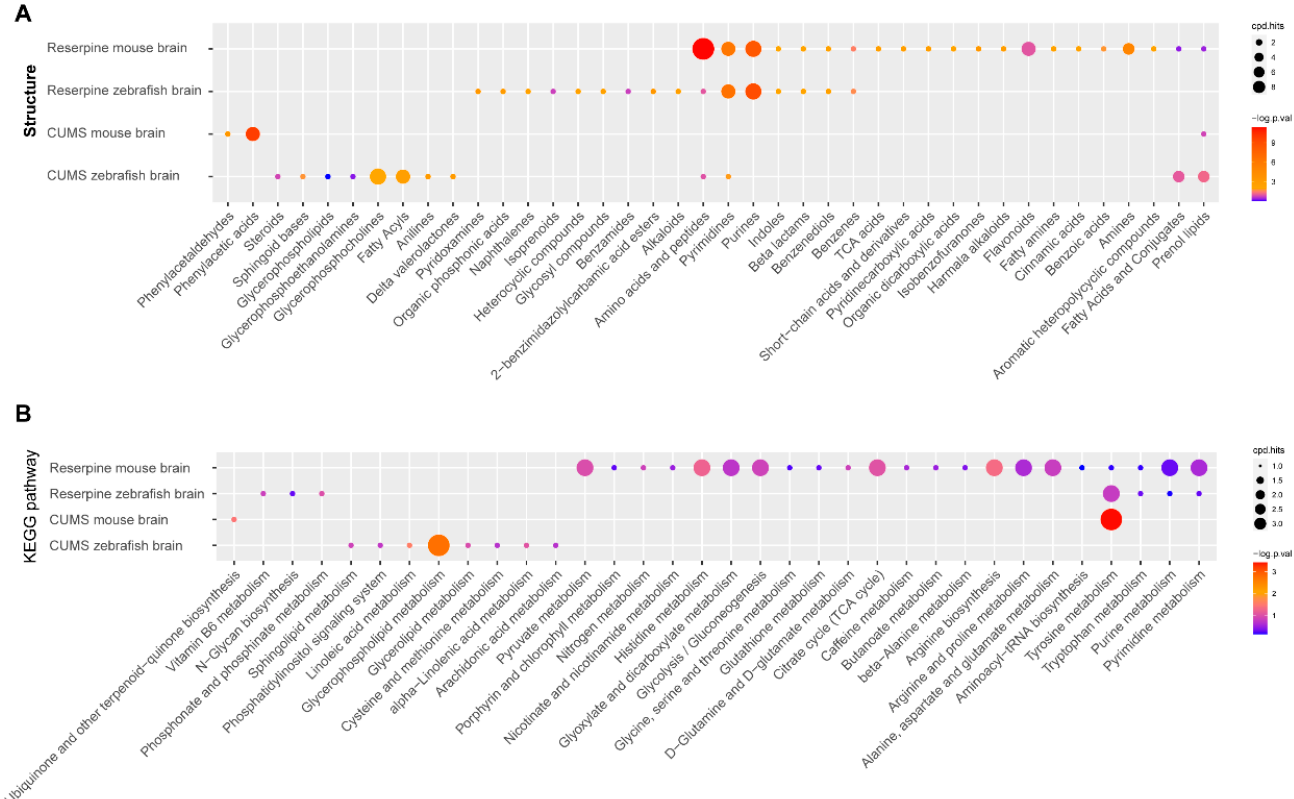
Figure 5. Metabolic analysis results of the four depression models. ( A ), the structure types of the metabolites. ( B ), the pathways of the metabolites.